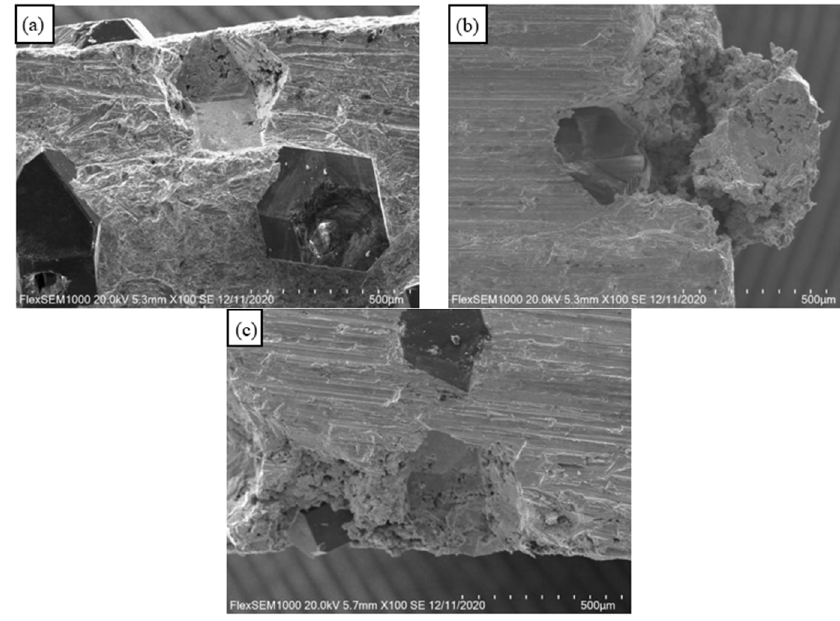
Figure 9. Defects of SD/Cu-Fe sandwich composite. ( a ) 740 °C; ( b ) 750 °C; ( c ) 780 °C.